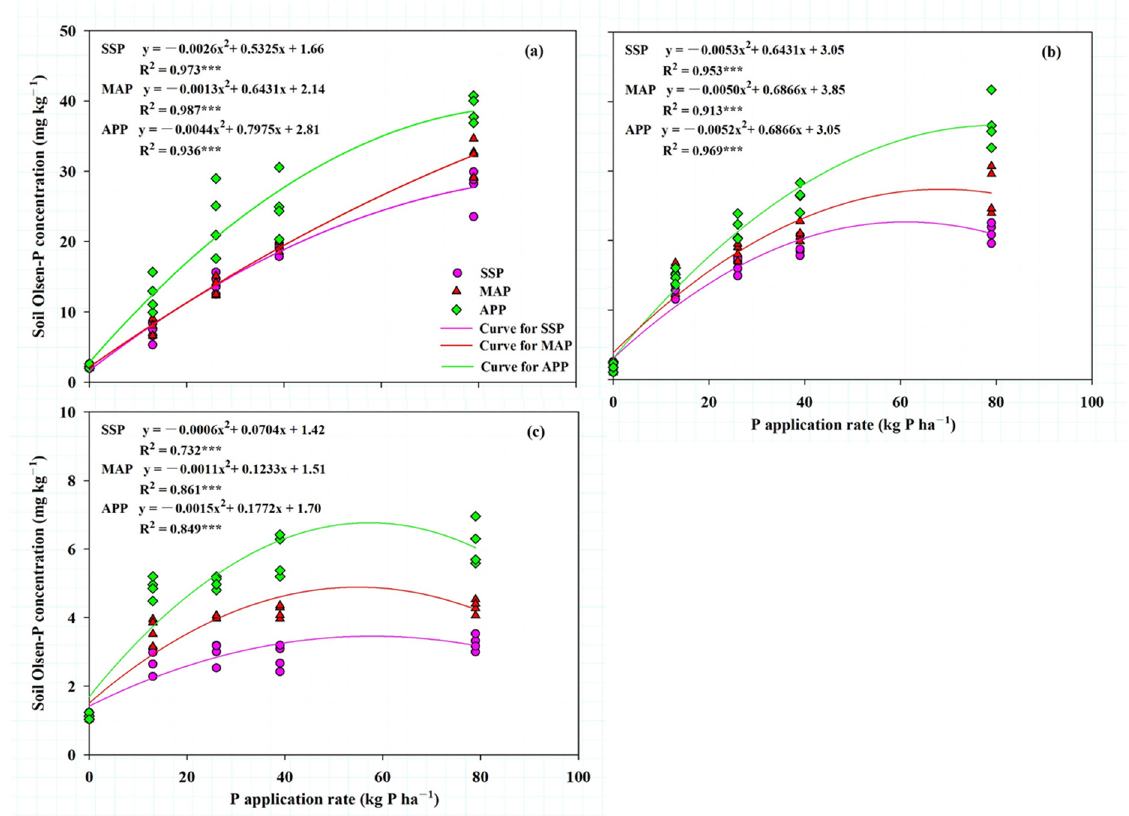
Figure 2. The response function of soil Olsen-P concentration to different P application rates at soil depths of 0–20 cm ( a ), 20–40 cm ( b ), and 40–60 cm ( c ) after wheat harvest in 2018–2019. SSP, superphosphate; MAP, monoammonium phosphate; APP, ammonium polyphosphate. *** significant at p < 0.01.